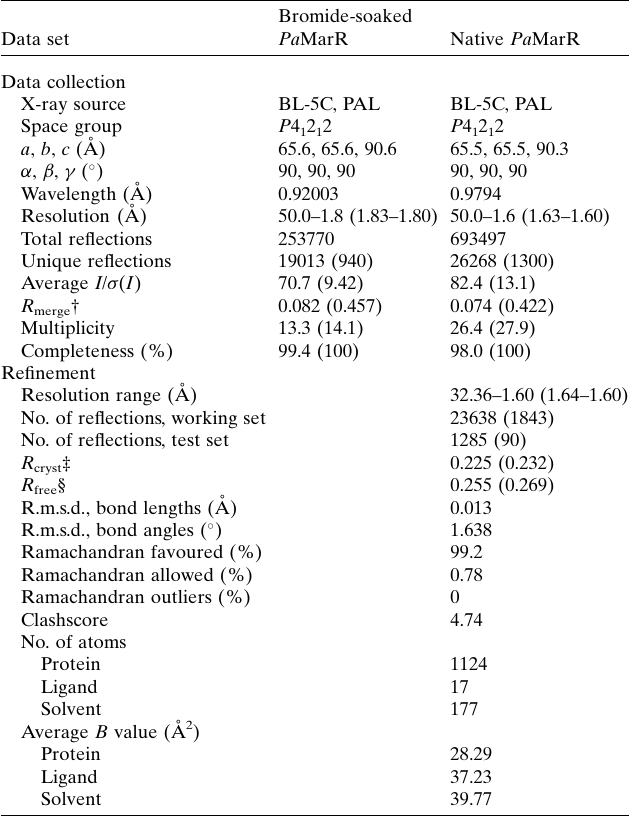
Table 1 X-ray diffraction data-collection and refinement statistics. Values in parentheses are for the highest resolution shell. Data